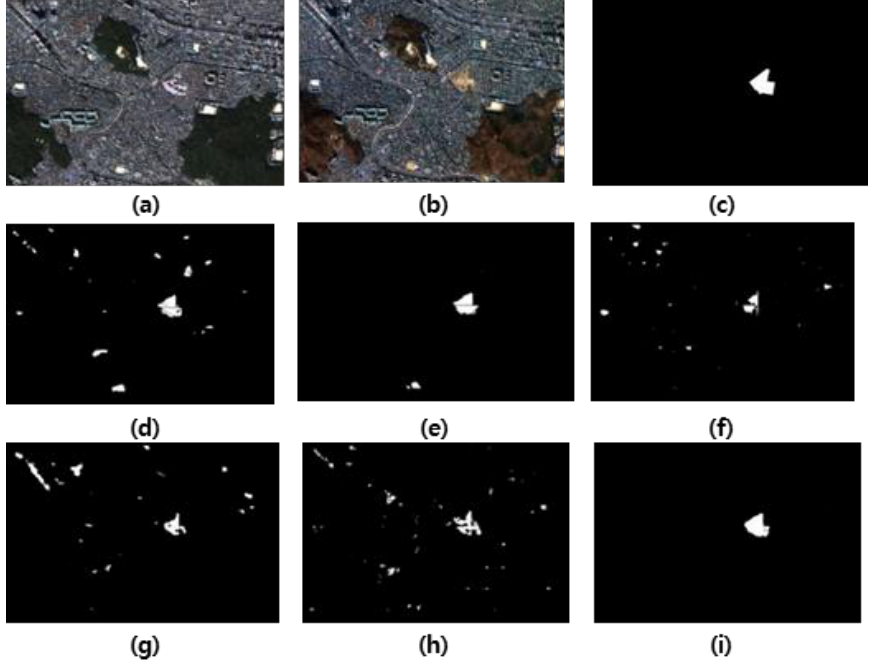
Figure 15. Changed detection maps of the proposed and conventional algorithms for “Test area 2” for the reverse input order: ( a ) Image P; ( b ) Image C; ( c ) Ground truth; ( d ) DI + UNet; ( e ) DI + AT- TUNet; ( f ) JF + UNet; ( g ) JF + ATTUNet; ( h ) Modified-UNet++; ( i ) Proposed Bilateral dissimilarity U-Net.